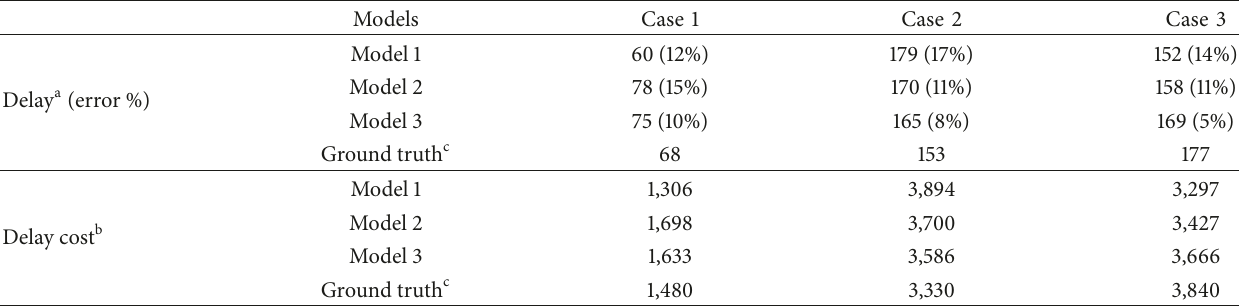
Table 3: Results comparison.